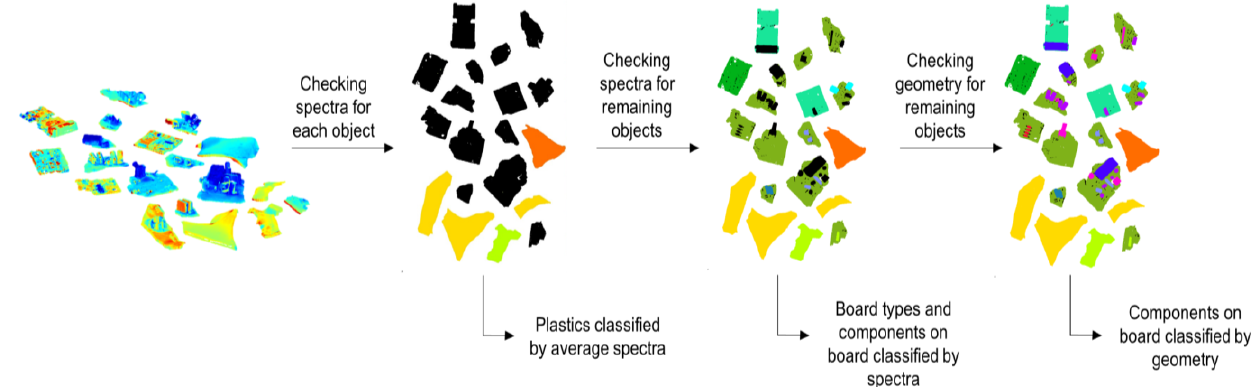
Figure 11. Steps of the rule-based classification process using spectral and spatial features for the rule formation. The geometrical information is not only used for structuring but also supports the classification of components that cannot be classified from their spectral signature only.